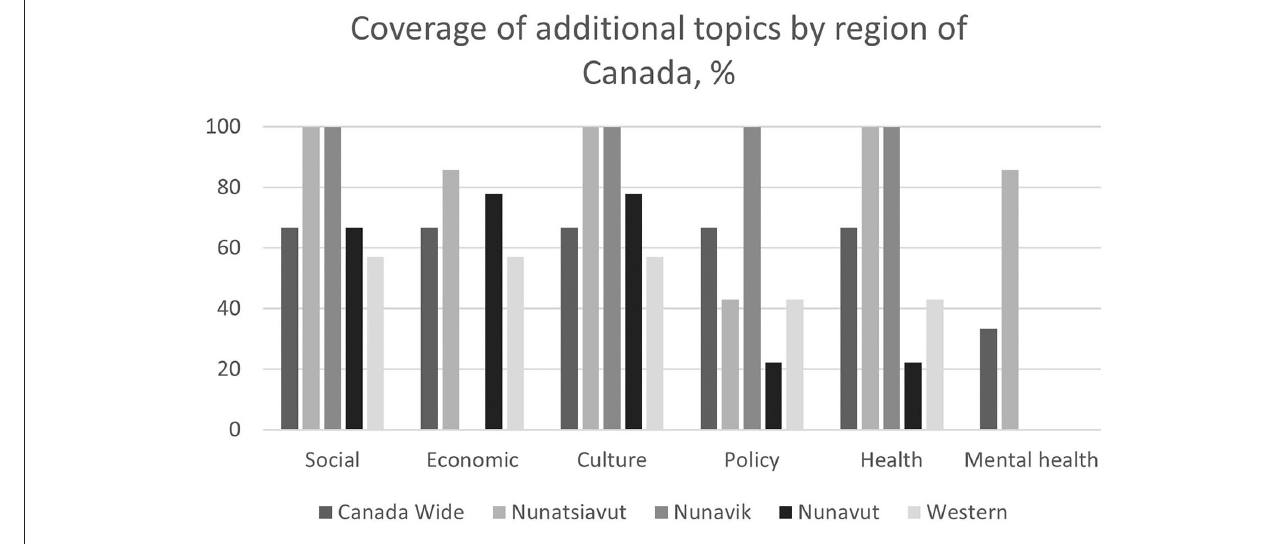
FIGURE 5 | Coverage of additional topics by region of Canada, % of total papers.